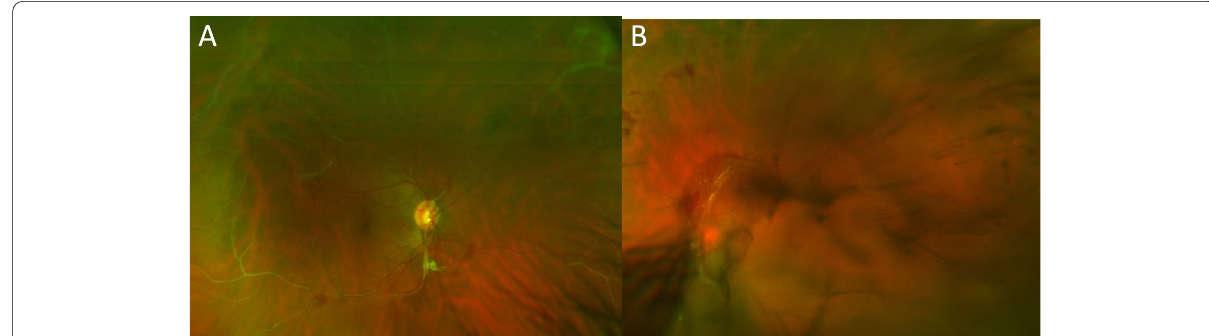
Fig. 1 Fundus photograph of the right eye at presentation ( A ) showing peripheral perivenous sheathing, fibrous proliferation along the superior and inferior vascular arcades, neovascularization of the optic disc, and macular ERN. The view of the left fundus is obscured by vitreous hemorrhage but posterior fibrovascular proliferation and peripheral sclerosed vessels are seen ( B )